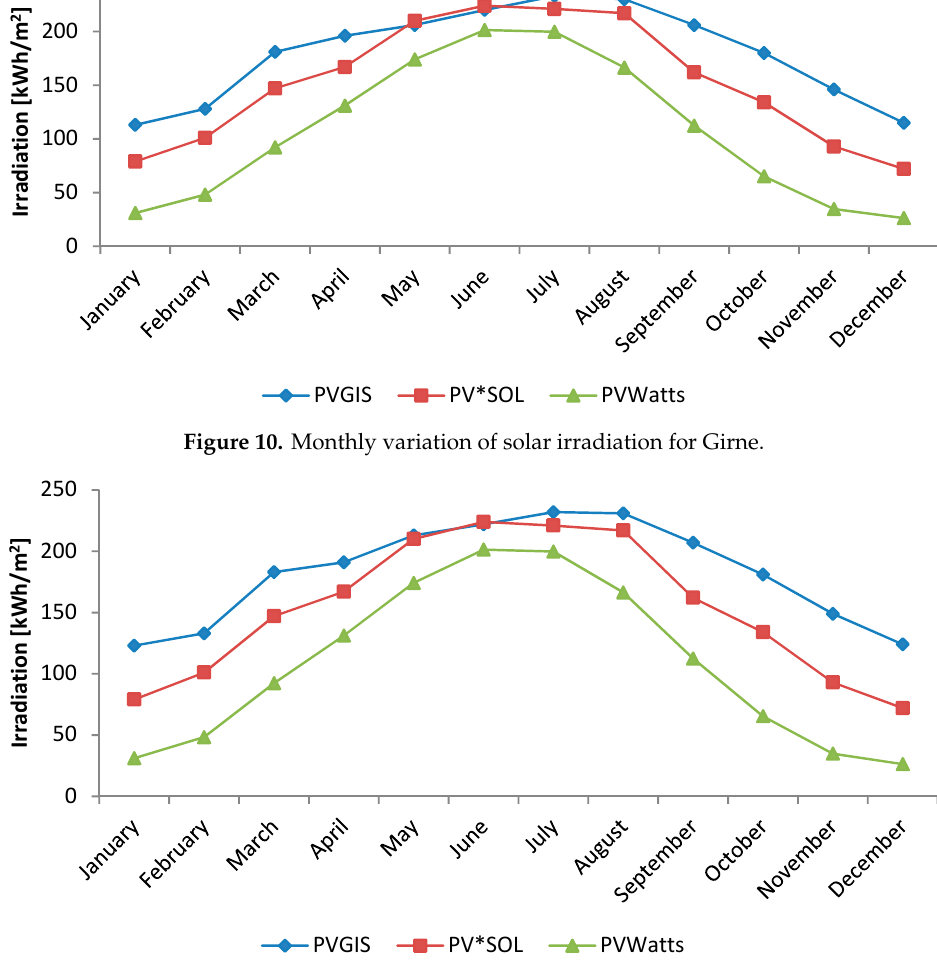
Figure 11. Monthly variation of solar irradiation for Gazima ğ usa.